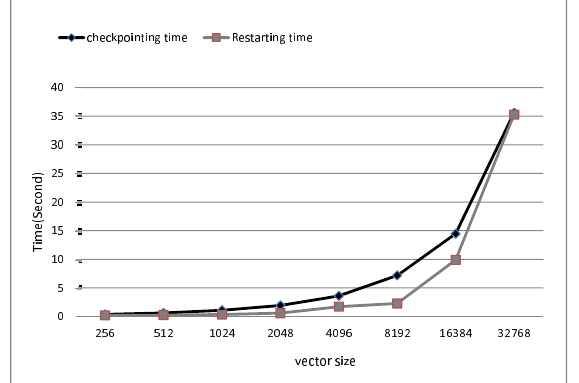
Fig. 17. Checkpoint/Restart Overhead with the Best Mode